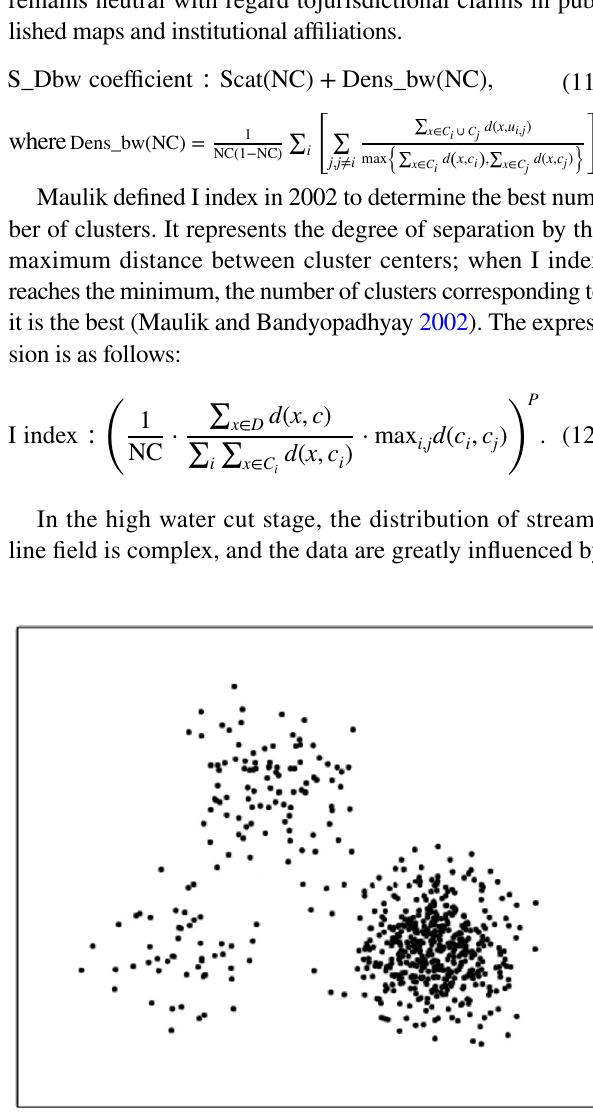
Table 1 Comparison of clustering effect verification methods under different numbers of clusters